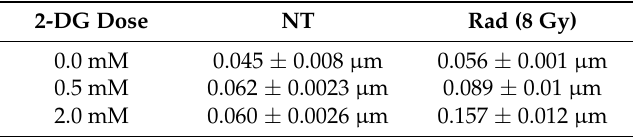
Table 2. ER diameter measurements in Glio14 treated with increasing doses of 2-DG and 8 Gy